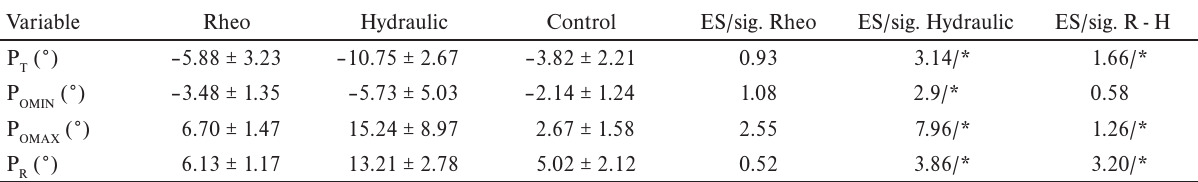
Comparison of pelvic movement parameters for patients with bionic knee joints (Rheo), patients with hydraulic knee joints (Hydraulic) and the control group (Control) Variable Rheo Hydraulic